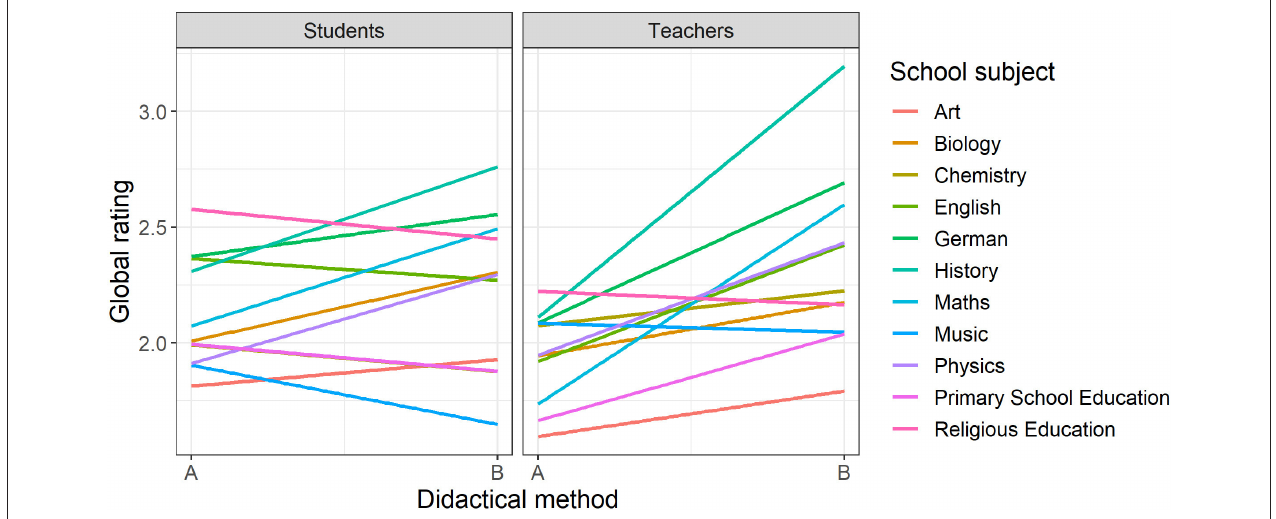
FIGURE 3 | Line graph of the subject-specific relationships between method and global rating, separated by students, and teachers.